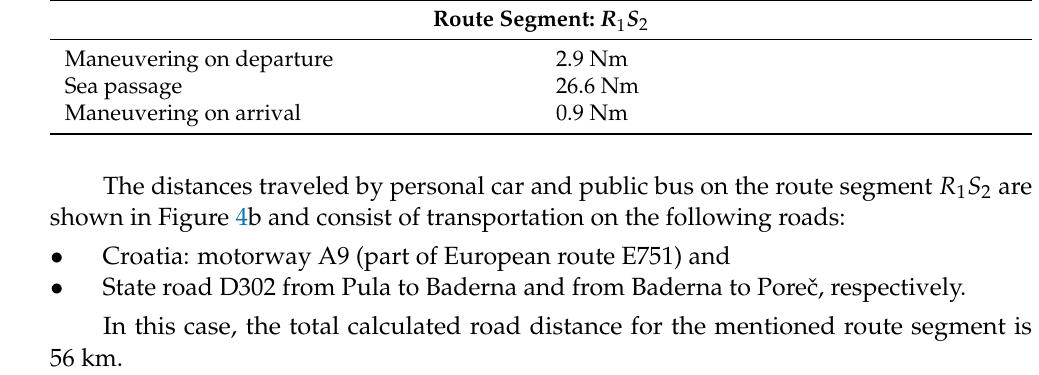
Figure 4. Route segment 𝑅 (cid:2869) 𝑆 (cid:2870) : ( a ) maritime transportation; ( b ) road transportation. Table 7. Distances traveled in the specific navigation mode on the route segment R 1 S 2 . Route Segment: 𝑹 𝟏 𝑺 𝟐 Maneuvering on departure